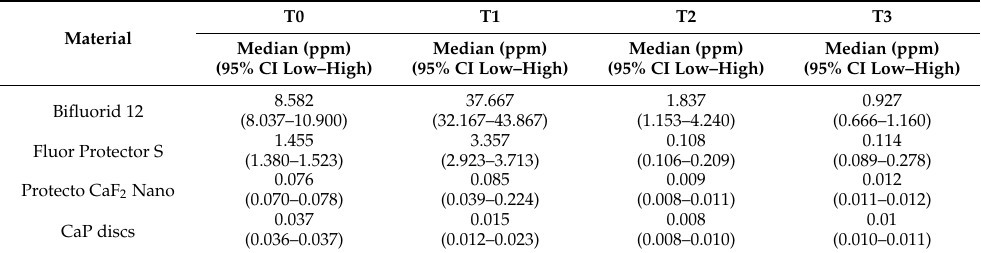
Table 3. Descriptive statistical values of fluoride ion release (in ppm) for the tested materials at all measurement